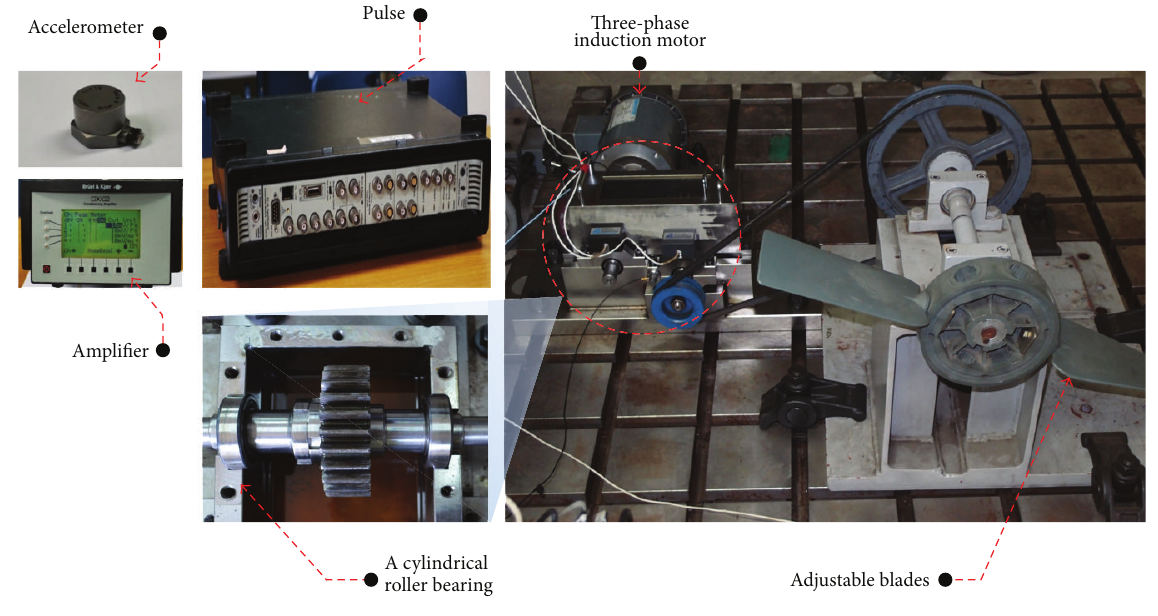
Figure 1: A self-designed fault